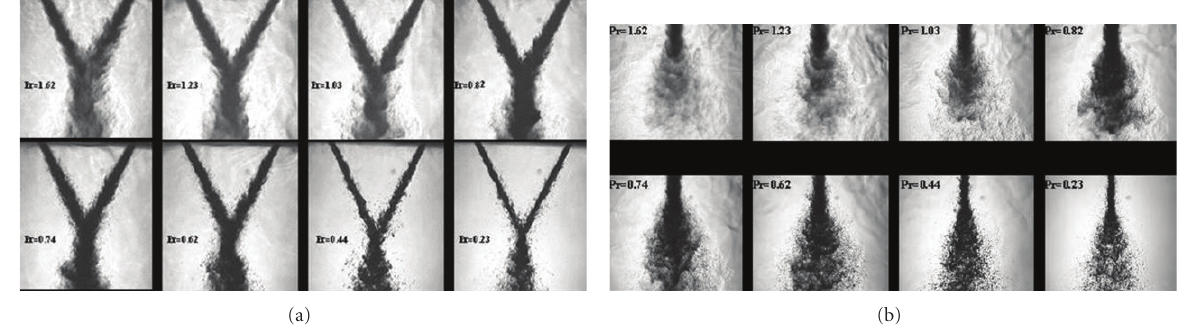
Figure 30: Instant images of sub-, near-, and supercritical impinging jets for LN 2 into GN 2 (room temperature) injection by Chehroudi. The last two rows show the same injector in the first two rows but viewed at a 90-degree angle. P ch = 0 . 8,1 . 5,2 . 1,2 . 5,2 . 8,3 . 5,4 . 2,5 . 5MPa; from lower right to upper left, P ch = 100,200,300,350,400,500,600,800psig. For nitrogen: P critical = 3 . 39MPa; T critical = 126 . 2K. Re = 25,000 to 70,000; holes’ length-to-diameter ( L / dn ) of ∼ 100; no cavitation; injection velocity: 10–15 m/s. Chehroudi